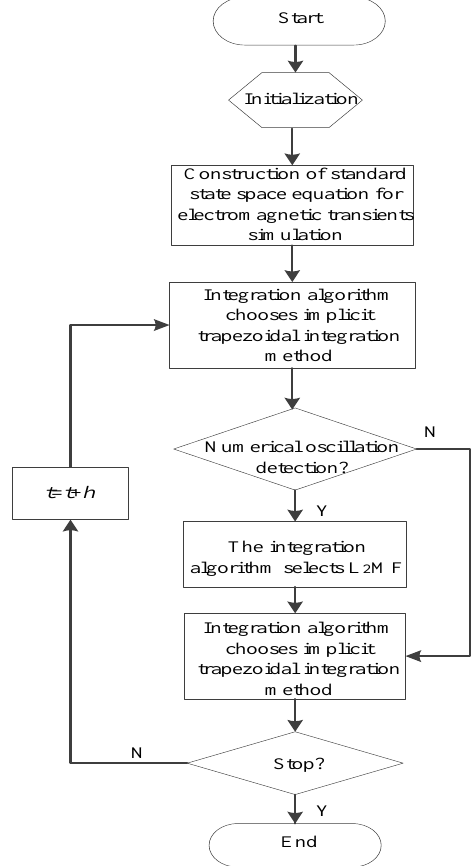
Figure 3. Flow chart of electromagnetic transient simulation in power systems on a basis of extended critical damping adjustment method (ECDA).